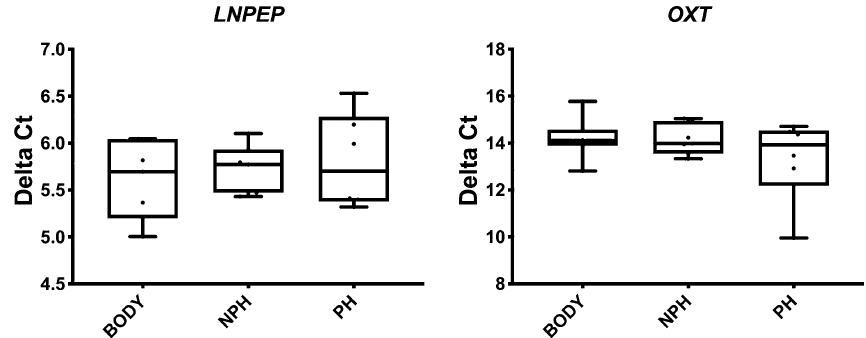
Figure 6. Relative abundance (Delta Ct) of LNPEP and OXT in the equine placenta Body, Non-pregnant horn (NPH) and Pregnant horn (PH). Delta Ct concentrations have an inverse relationship to mRNA